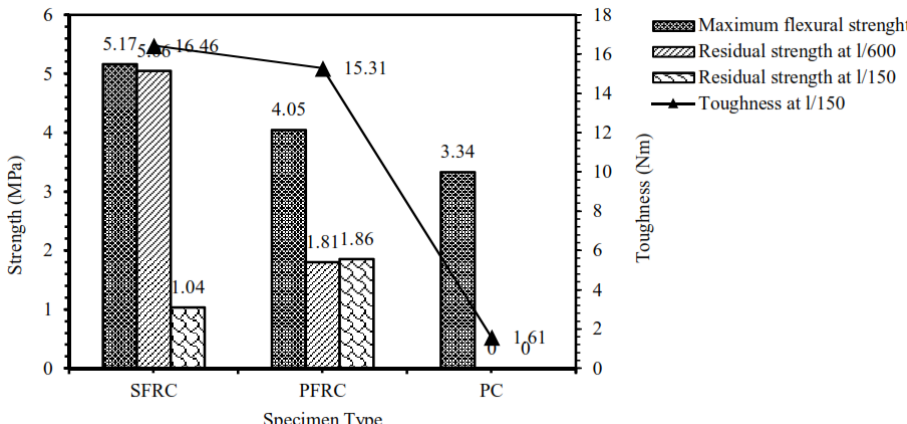
Figure 7: Several flexural features of the tested specimens